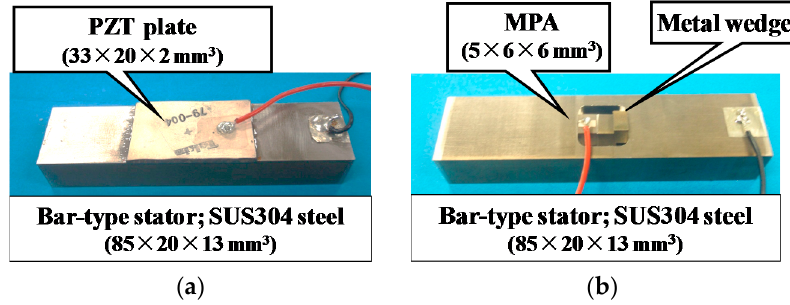
Figure A1. Photographs of rectangular bar vibrators. ( a ) Bonded PZT plate and ( b ) Embedded MPA. Table A1. Physical and piezoelectric properties of PZT and MPA.